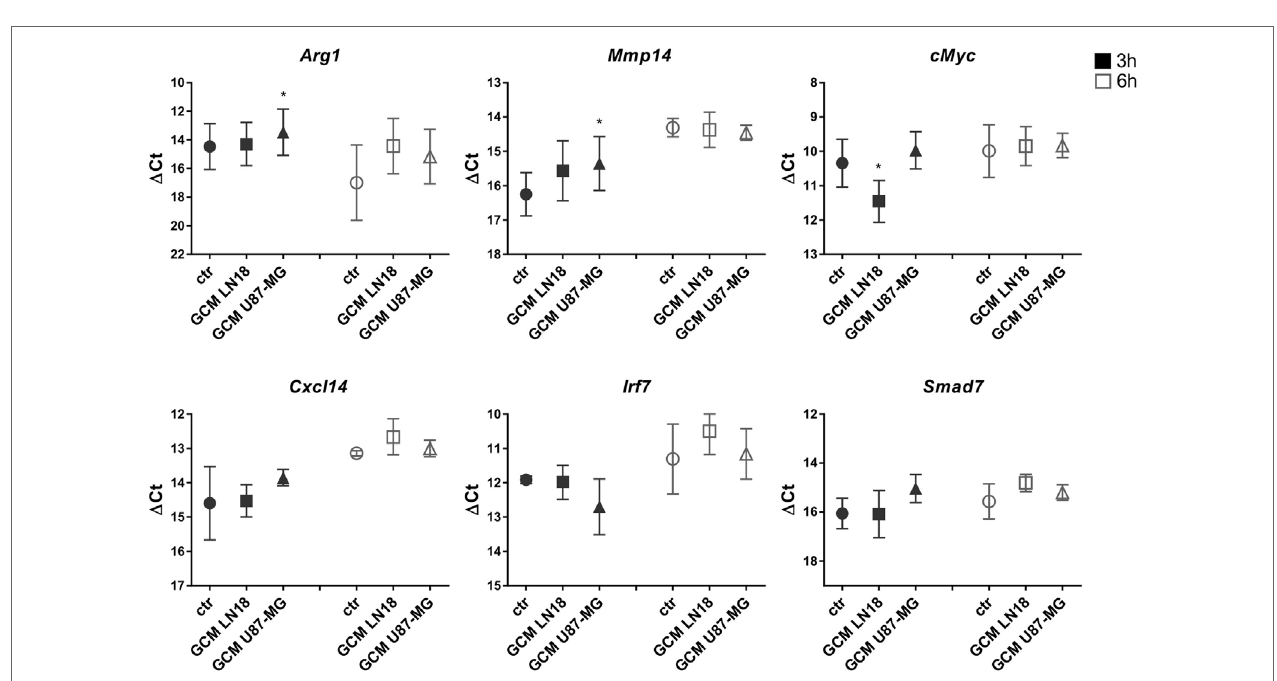
FigUre 2 | The expression of selected genes in glioma-conditioned medium (GCM) stimulated primary murine microglia cultures. Gene expression was determined by qRT-PCR in microglial cultures left untreated (circles), treated with GCM from LN18 (squares), or U87-MG (triangles) for 3 h (black) and 6 h (white). Data are shown as delta Ct values relative to 18S expression. Assessment of statistical significance was performed using one-way ANOVA test, followed by Dunnett’s multiple comparison test. The results are calculated as means ± SD, n ≥ 3. Differences at p < 0.05 were considered as significant (*** p < 0.001, ** p < 0.01, and * p < 0.05).